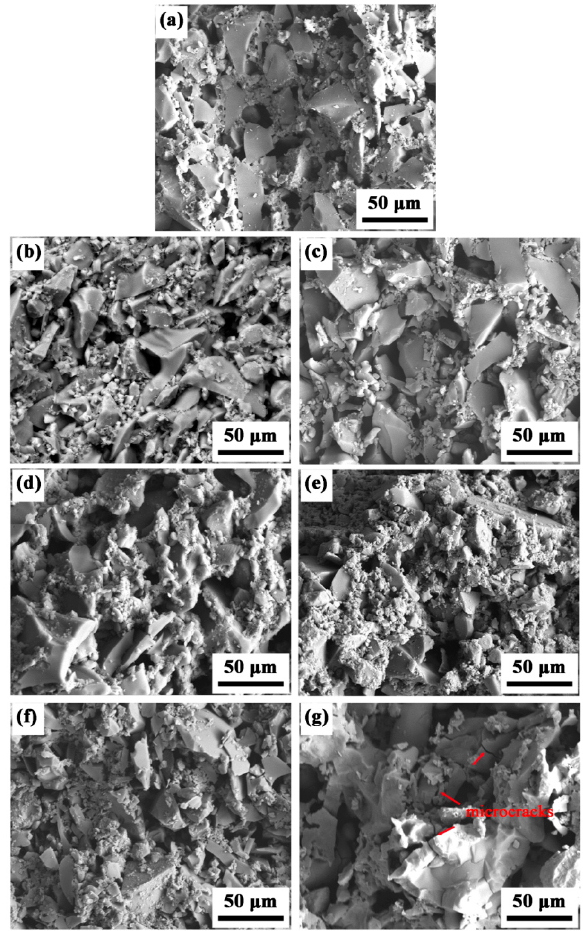
Figure 7. Micrographs imaged from the fracture surfaces of the different ceramic cores: ( a ) M0; ( b ) FM5; ( c ) SM5; ( d ) FM10; ( e ) SM10; ( f ) FM15; ( g ) SM15.